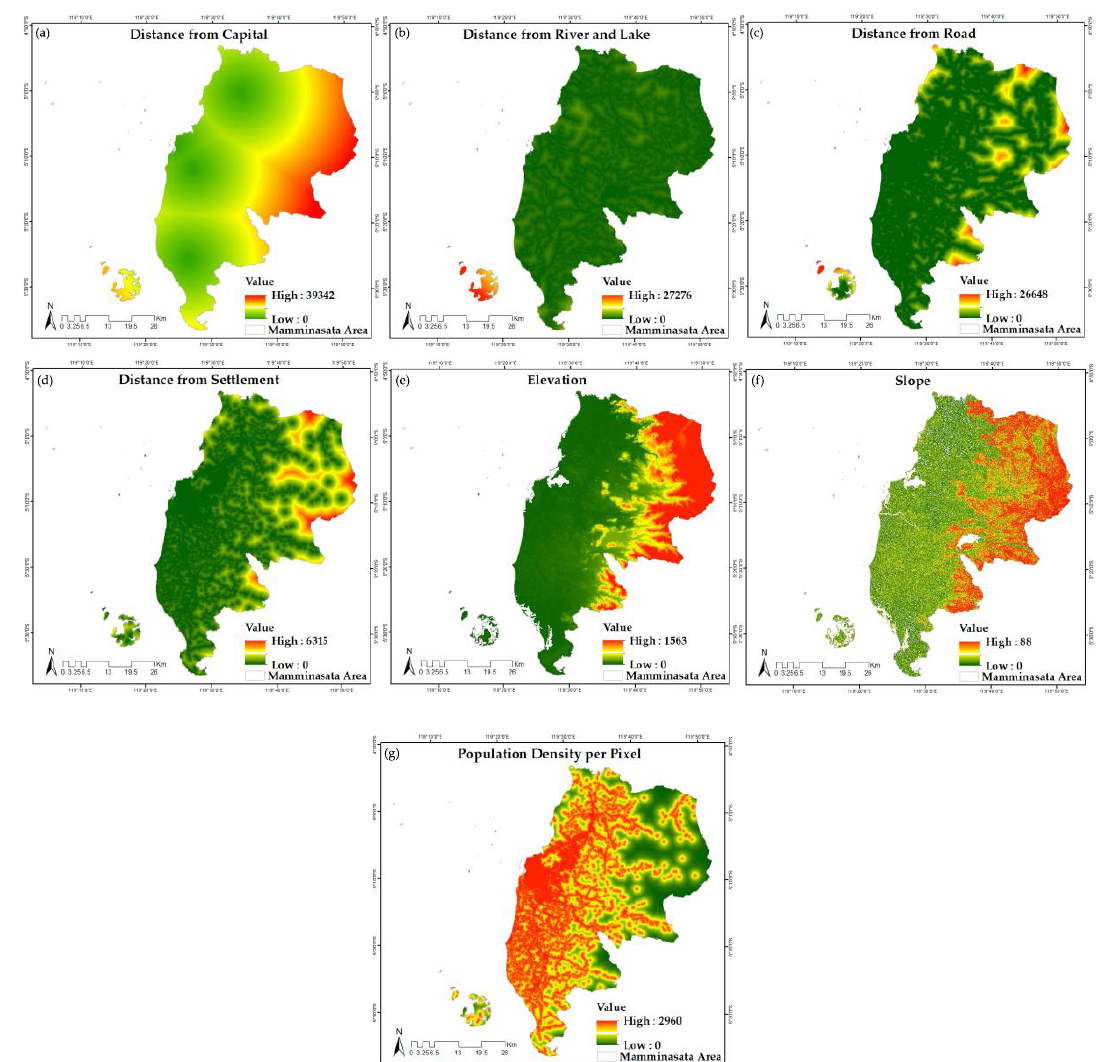
Figure 7. Driving factor maps: ( a ) distance from capital, ( b ) distance from river and lake, ( c ) distance from road, ( d ) distance from settlement, ( e ) elevation, ( f ) slope, and ( g ) population density per pixel. Distances and elevation are in meters, slope is in degrees, and population density per pixel is in people/km 2 . Table 5. Cramer’s V values of driving